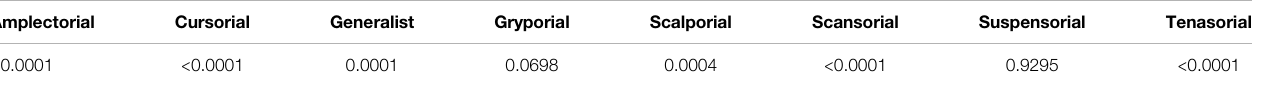
TABLE 1 | Posterior probabilities for the assignment of Anthracodromeus to the eight functional groups.